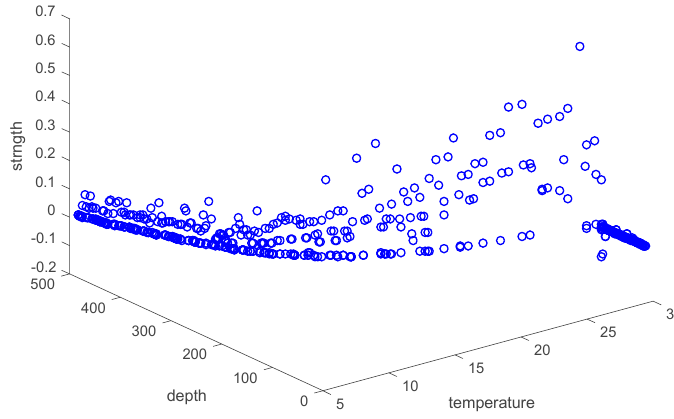
Figure 11. Attribute space made up of temperature, strength and depth.